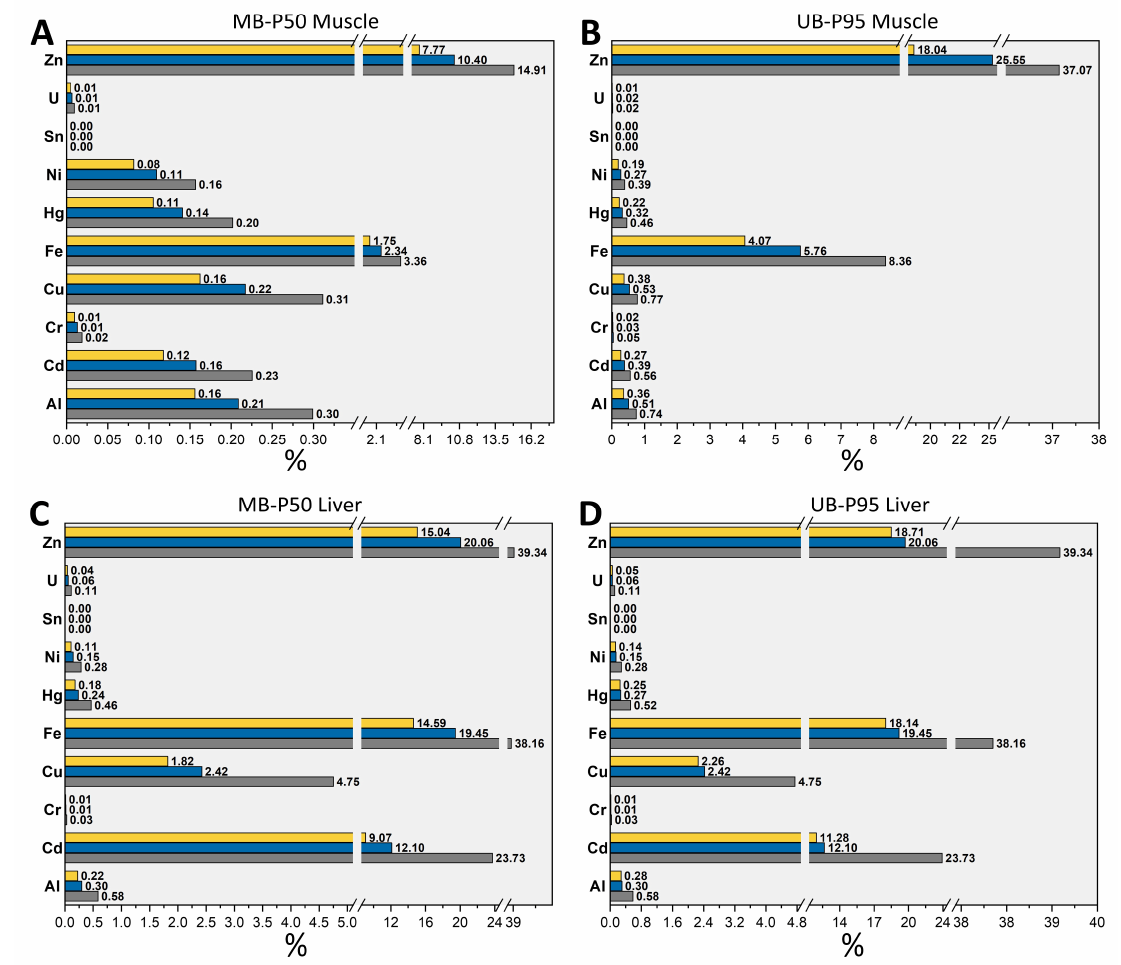
Figure 3. Contribution percentages of pig meat ( A , B ) and pig liver ( C , D ) consumption to the HBGVs of Al, Cd, Cr, Cu, Fe, i Hg, Ni, Sn, U, and Zn according to the estimated less pessimistic (MB-P50, A , C ) and worst-case (UB-P95, B , D ) dietary exposure scenarios for Italian population age groups (yellow bars: adults; blue bars: adolescents; gray bars: